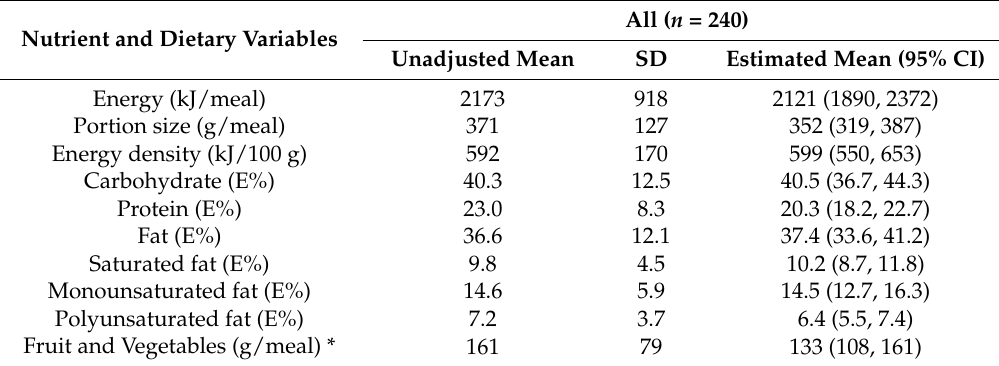
Table 3. Unadjusted and estimated mean intake for all